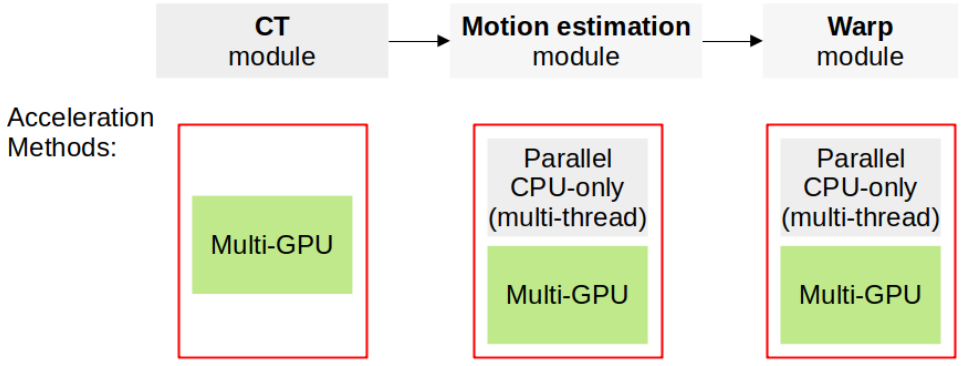
Figure 2. Structure of the algorithm [12]; for each block, we studied the acceleration method shown in the boxes. The composition of the green boxes creates the proposed fastest